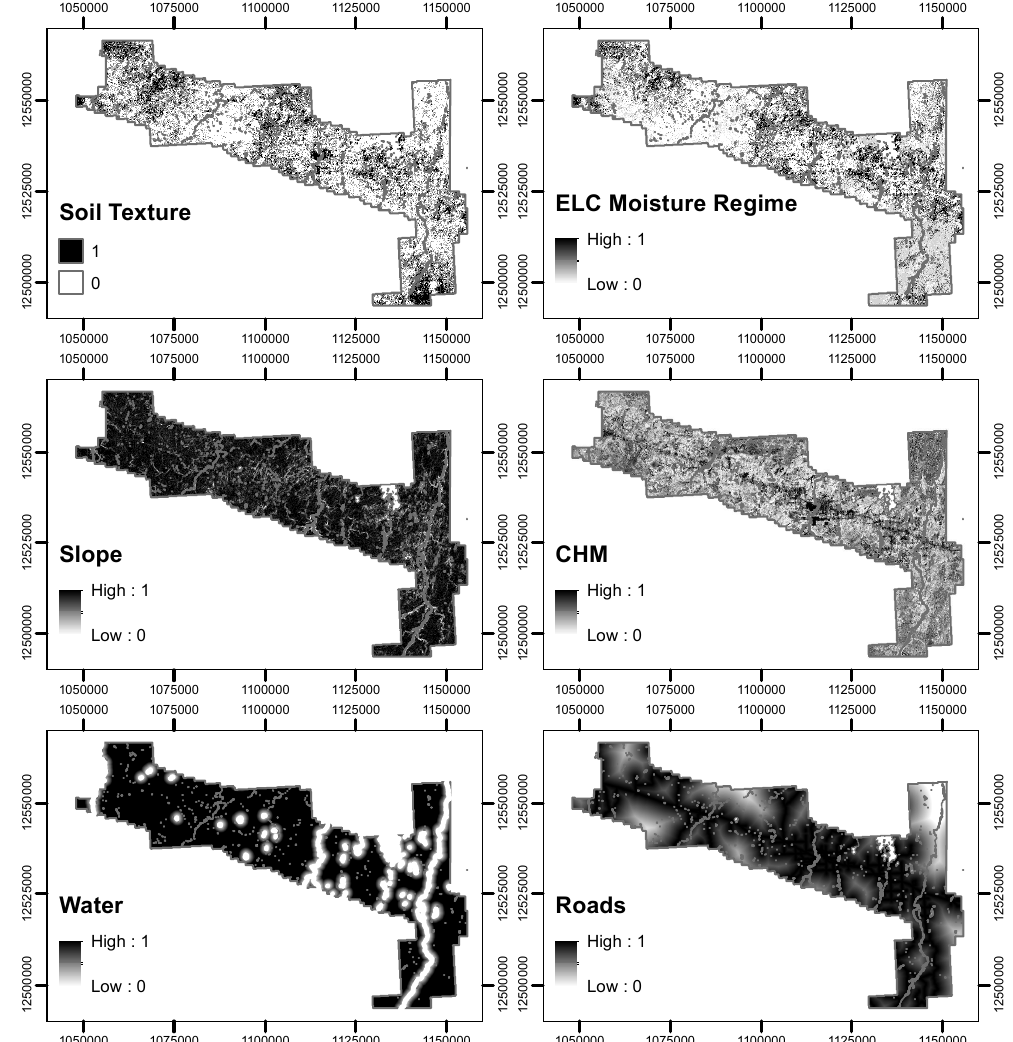
Figure 3. Attribute layers renormalized to common scale via fuzzy logic inference. Note that 0 denotes the least preferability, whereas 1 denotes the most